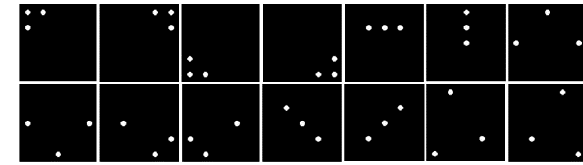
Figure 6: Patterns used for the experiment.